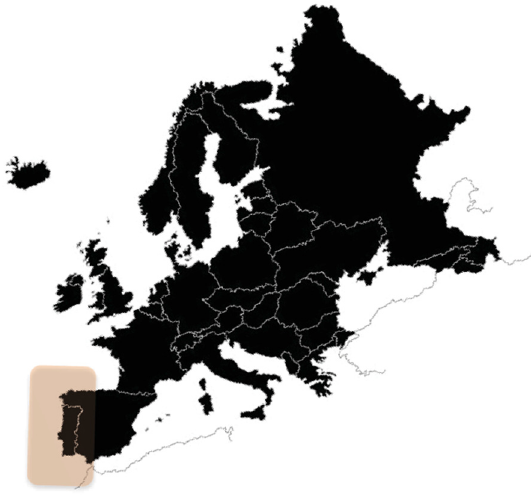
Figure 1. Location of the Western Iberia Coast (WIC).